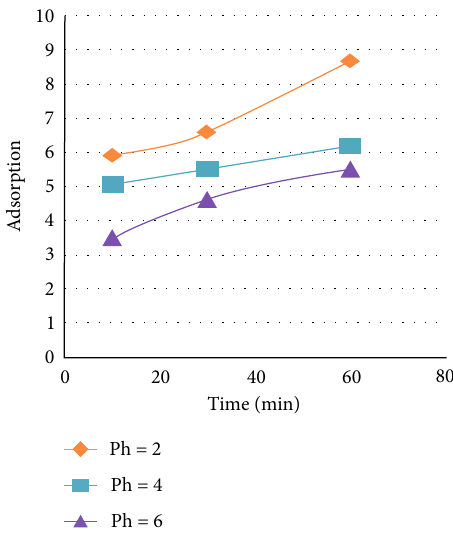
Figure 8: The relationship of time to adsorption for di ff erent values of the acidity function at a concentration of